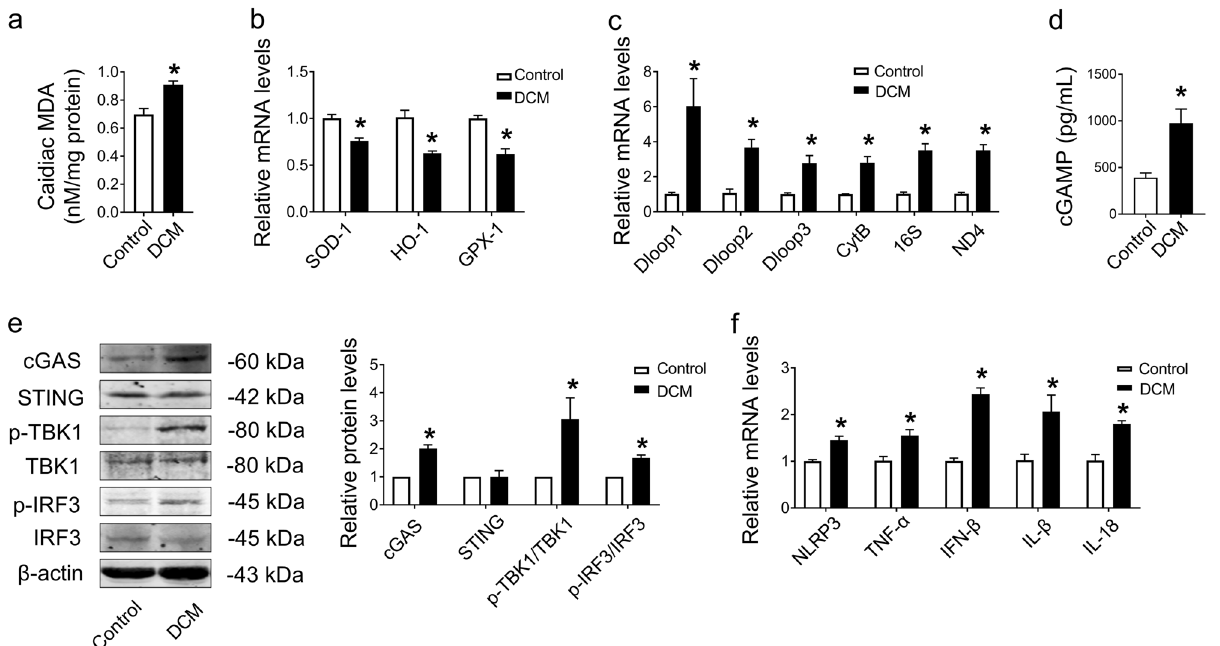
Fig. 1 Oxidative stress-induced leakage of mtDNA and activation of the cGAS-STING pathway accompanied with in fl ammation in DCM mice hearts. a Assessment of the level of MDA in fresh heart tissues. n = 3 in each group. b mRNA levels of SOD-1, HO-1, and GPX-1 determined in tissues by qRT – PCR. n = 3 in each group. c mRNA levels of Dloop1, Dloop2, Dloop3, CytB, 16S, and ND4 determined in tissues by qRT – PCR. n = 3 in each group. d The contents of cGAMP in the hearts of DCM mice. n = 7 in each group. e Representative protein levels of cGAS, STING, p-TBK1/TBK1, and p-IRF3/IRF3 normalized to β -actin in heart tissues by western blot. n = 3 in each group. f mRNA levels of NLRP3, TNF- α , IFN- β , IL-1 β , and IL-18 in tissues. n = 3 in each group. The results were normalized to β -actin. Values are the mean ± SEM. * P < 0.05 vs. the control group. DCM diabetic cardiomyopathy, MDA